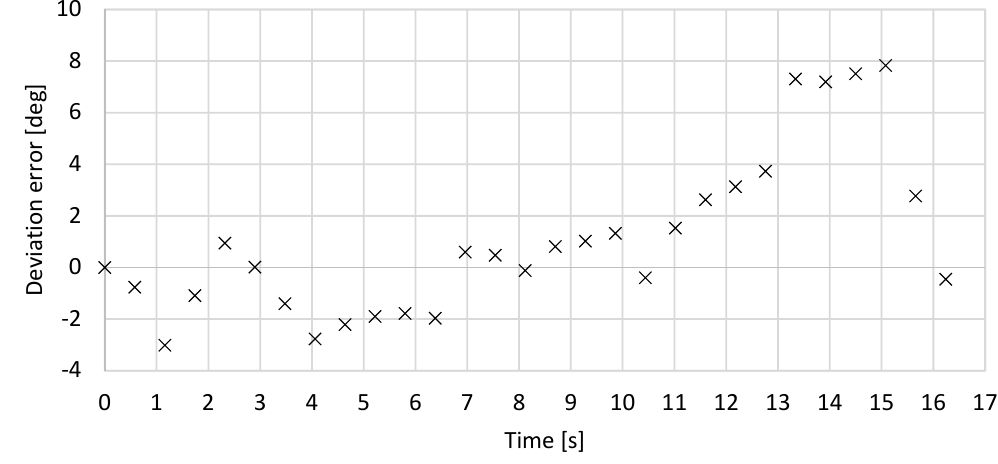
Figure 24. Computed deviation error of β versus time.